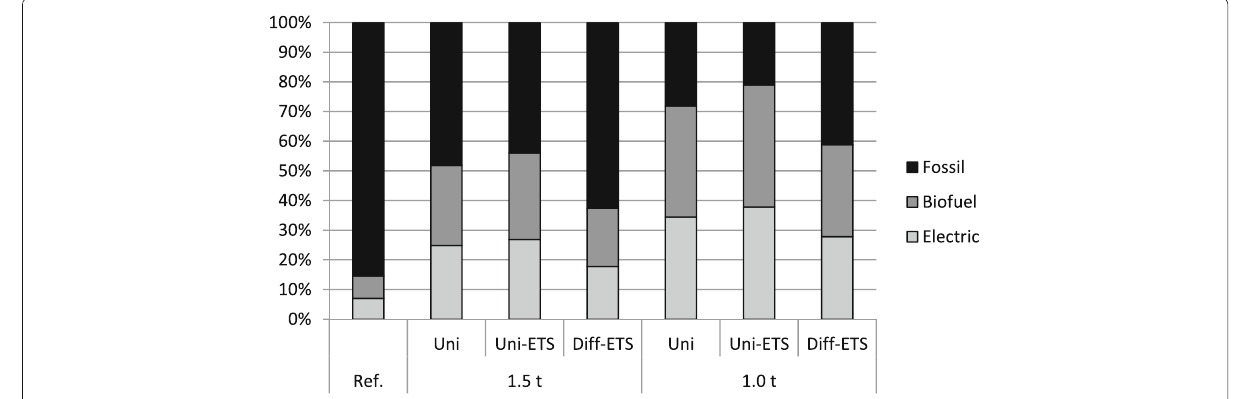
Fig. 4 Share of each vehicle type in distance travelled in percentage in 2050—other